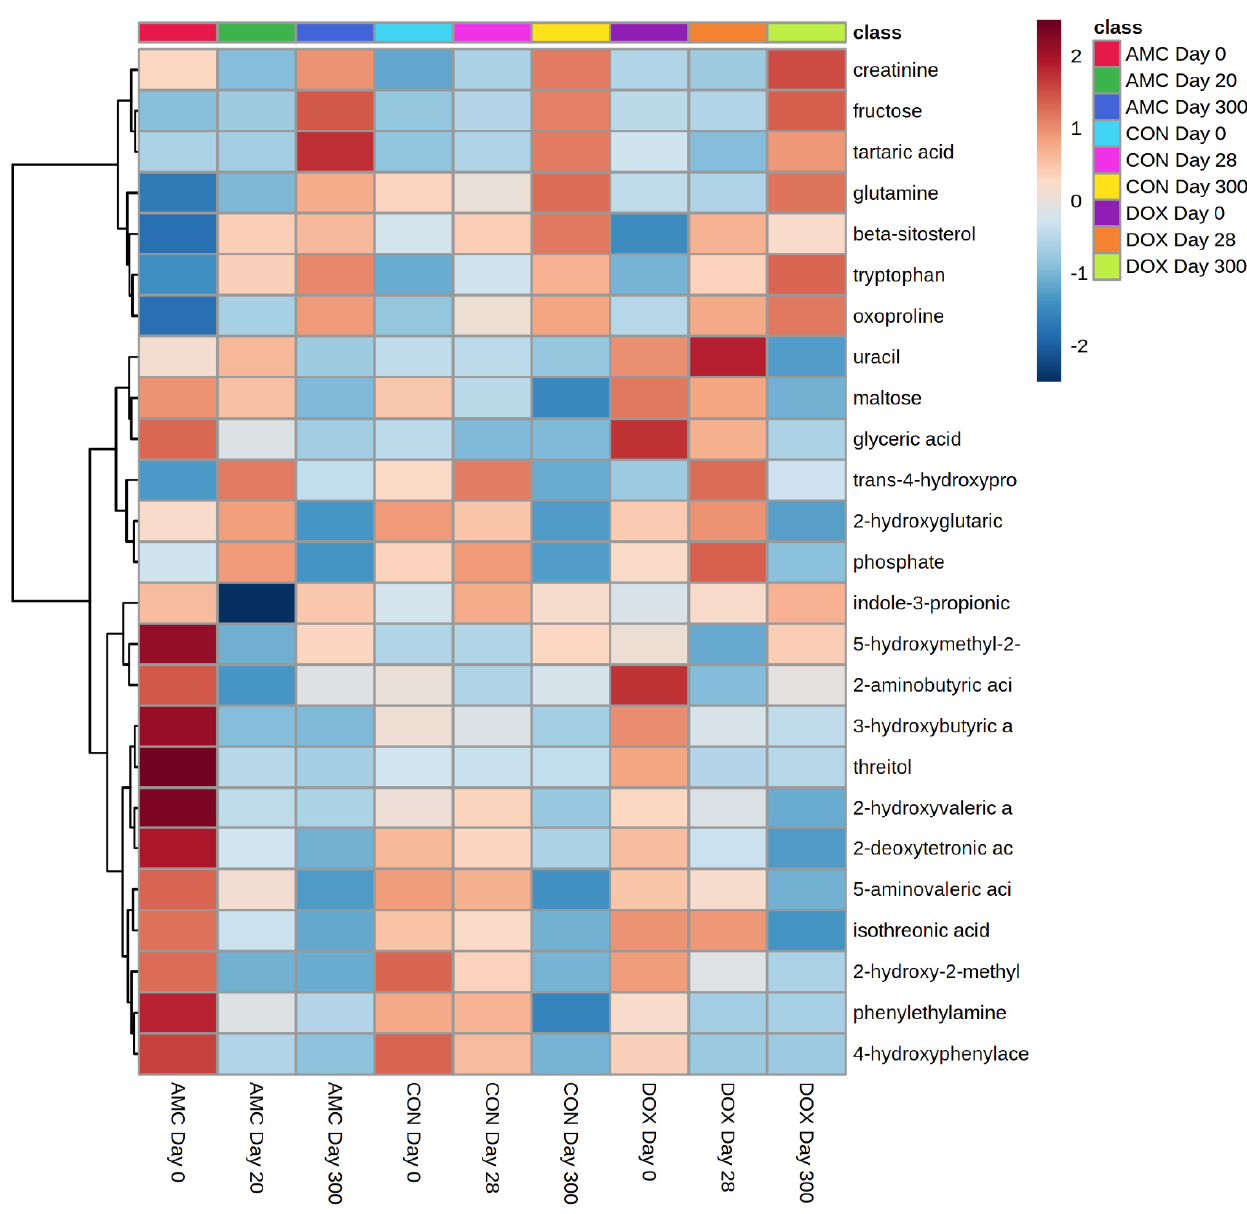
Figure 5. Heatmap clustering metabolites in serum of AMC, CON, and DOX cats over time (days 0, 20/28, 300). For simplicity, the figure only displays the average intensities of the top 25 metabolites that were different ( q < 0.05) based on the ANOVA. The higher the signal intensity of a metabolite, the more intensely red the metabolite shows. The lower the signal intensity of a metabolite, the more intensely blue the metabolite shows in the heat map. Each row corresponds to a single metabolite. Each column represents the average intensity of a metabolite at a given sampling time within AMC, CON, and DOX groups, and samples are grouped by day within each treatment group along the